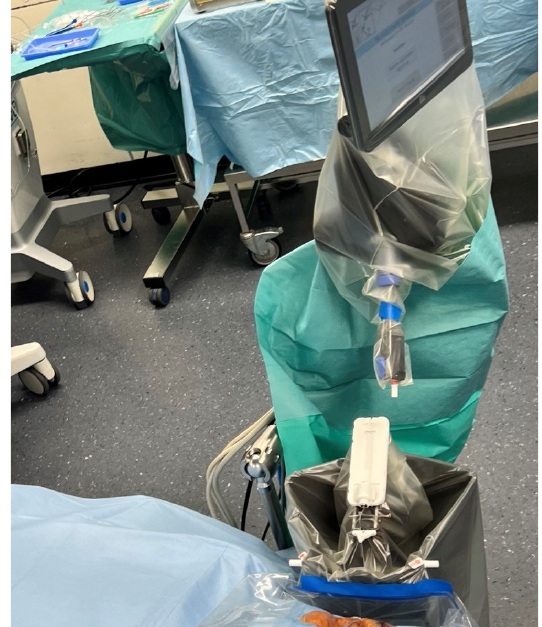
Figure 3. The draping of the PSS contains the instrument manipulator, trocar holder, motion controller, and cables. The extra draping, which maintains the sterility of the instrument manipulator during the introduction of anesthesia, has already been removed.